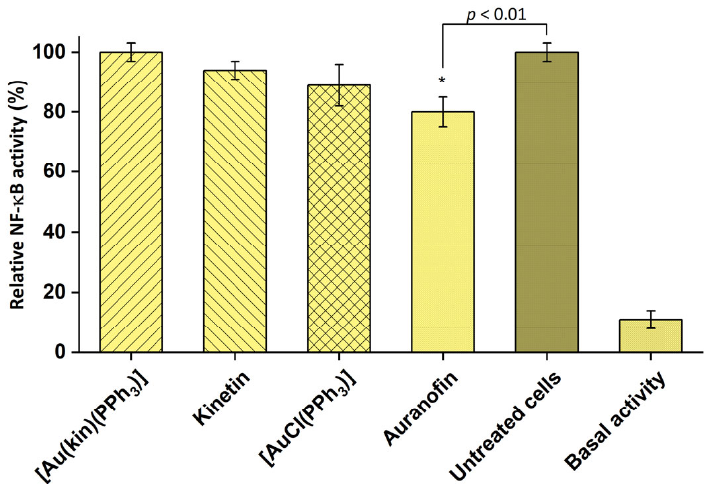
Figure 9. Effect of the tested compounds on NF- κ B activity in THP1-Blue™ NF- κ B monocytes. Effect of 1 h pre-treatment on LPS-stimulated NF- κ B activity detected after 24 h. The statistical significance was considered at the * p < 0.01 level as compared to the vehicle (DMF) group. Data are shown as means ± SEM.